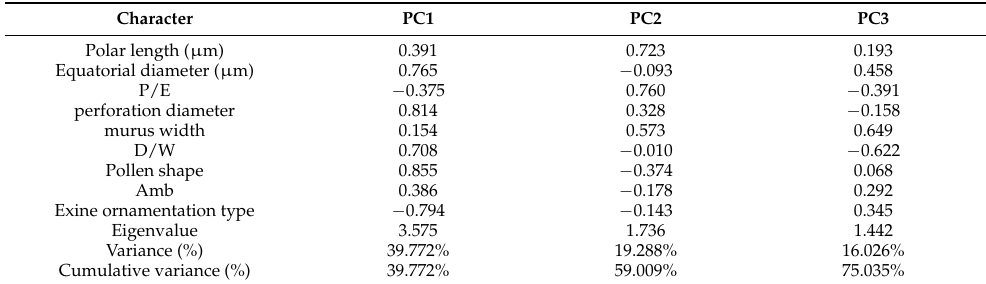
Table 4. Nine values and results of the first three principal components (PCAs) analysis for the pollen characteristics in the tree peony